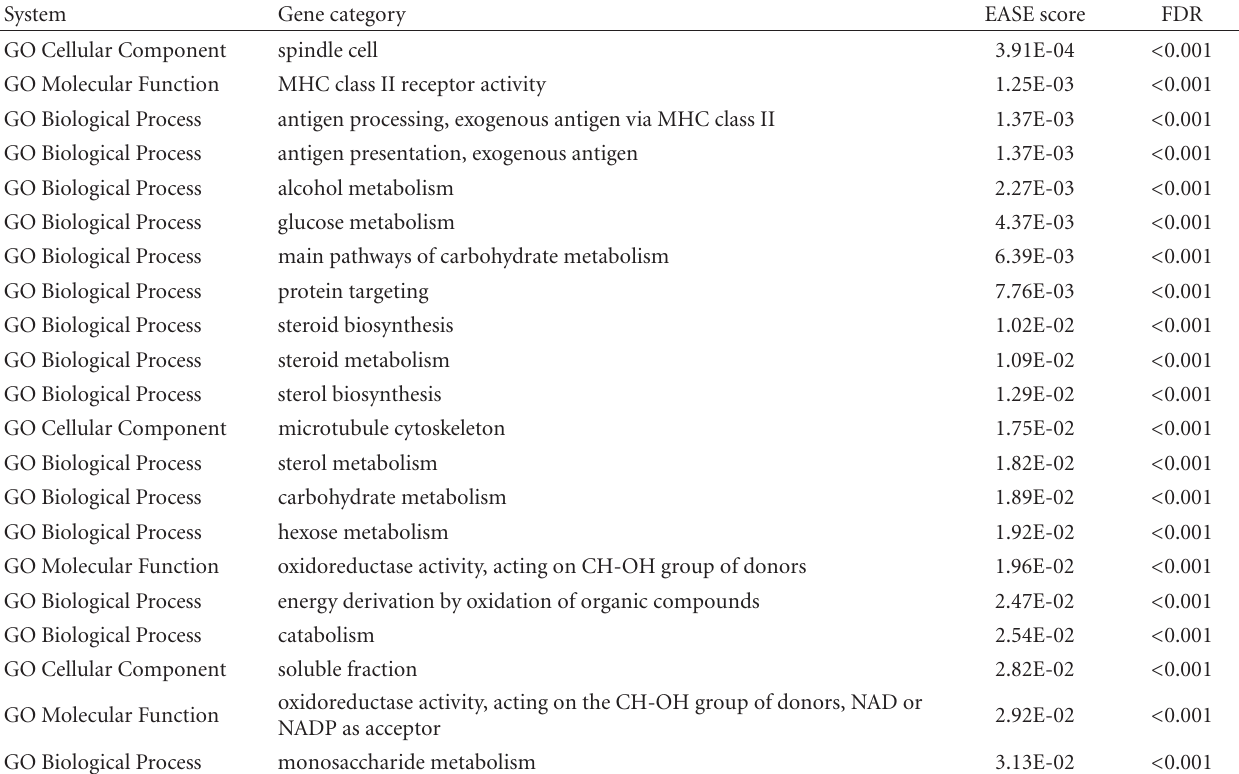
Table 5: Categories of genes with expression increase of 2-fold or more in Il10 − / − mice compared to C57 mice at 7 weeks of age using EASE.